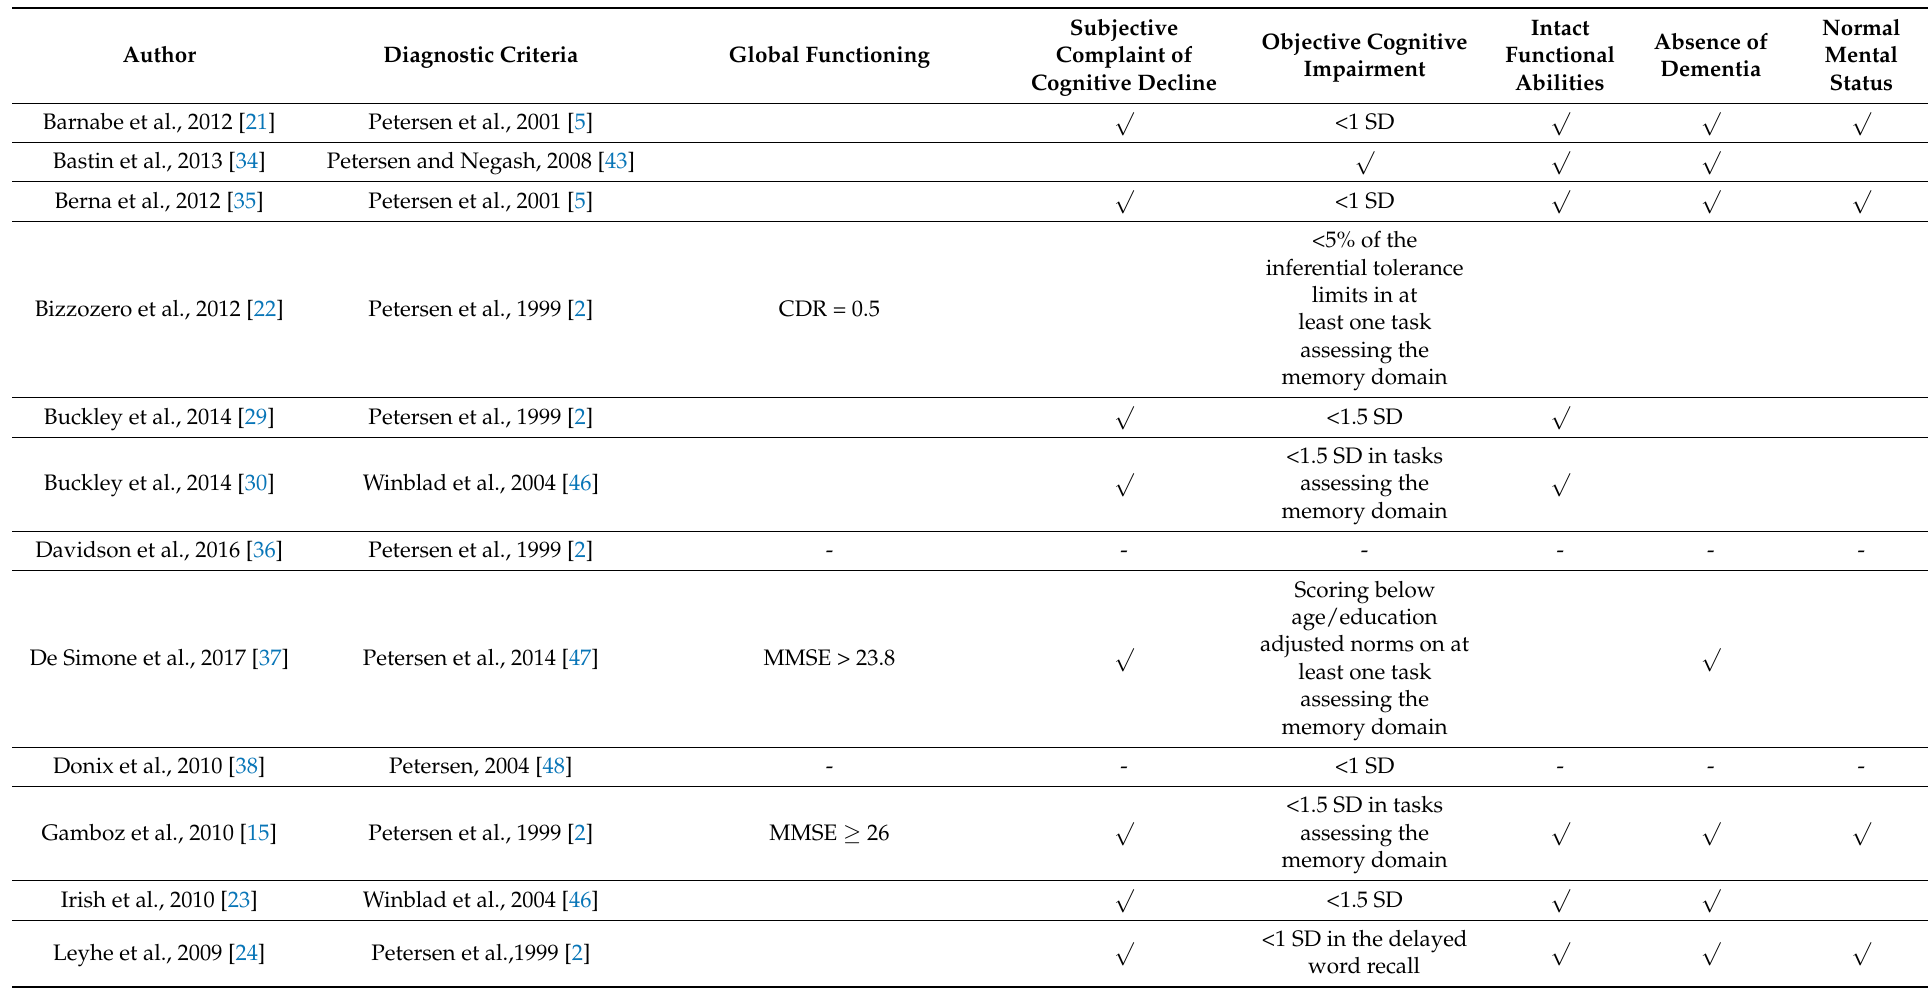
Table 4. Diagnostic